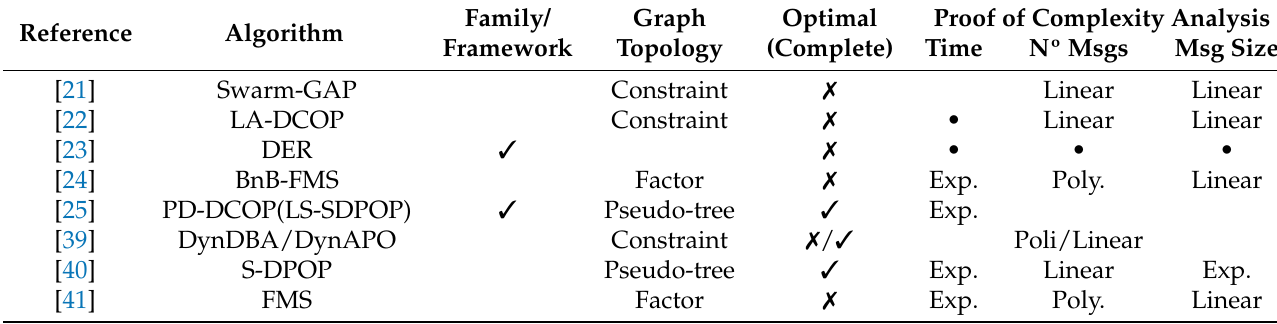
Table 6. Dynamic DCOP properties from SMS included papers. Optimality and Graph representations and Proof of time and spatial complexity such as Exponential, Polynomial, or Linear growing from algorithms are included.